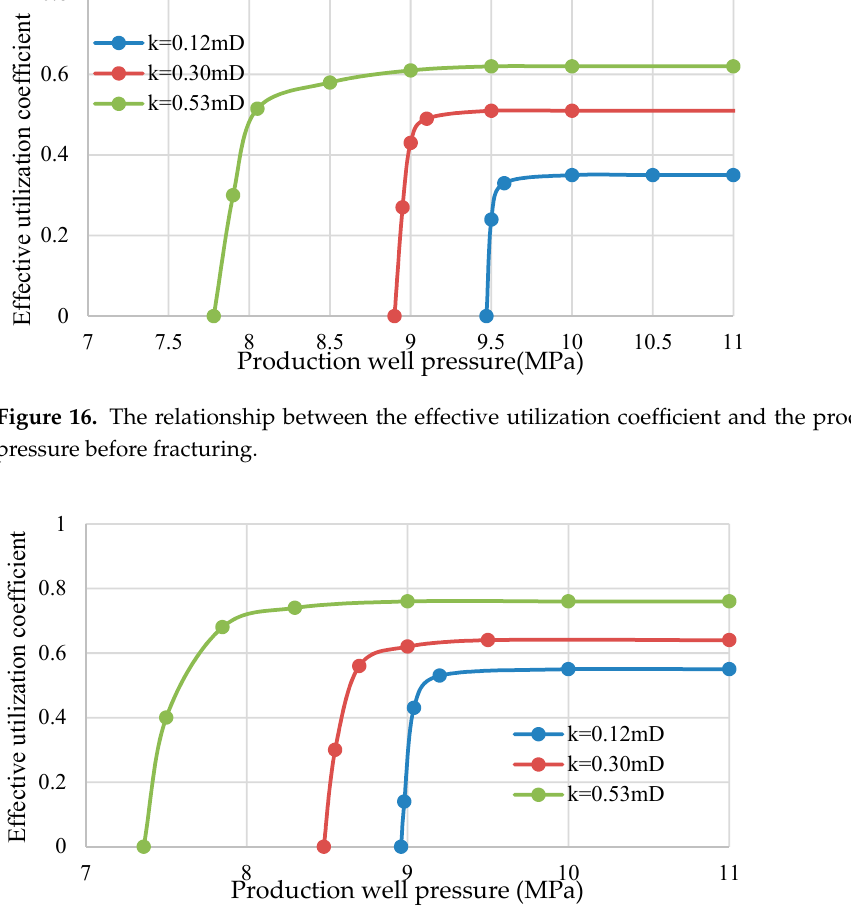
Figure 17. The relationship between the effective utilization coefficient and the production well pressure after fracturing.